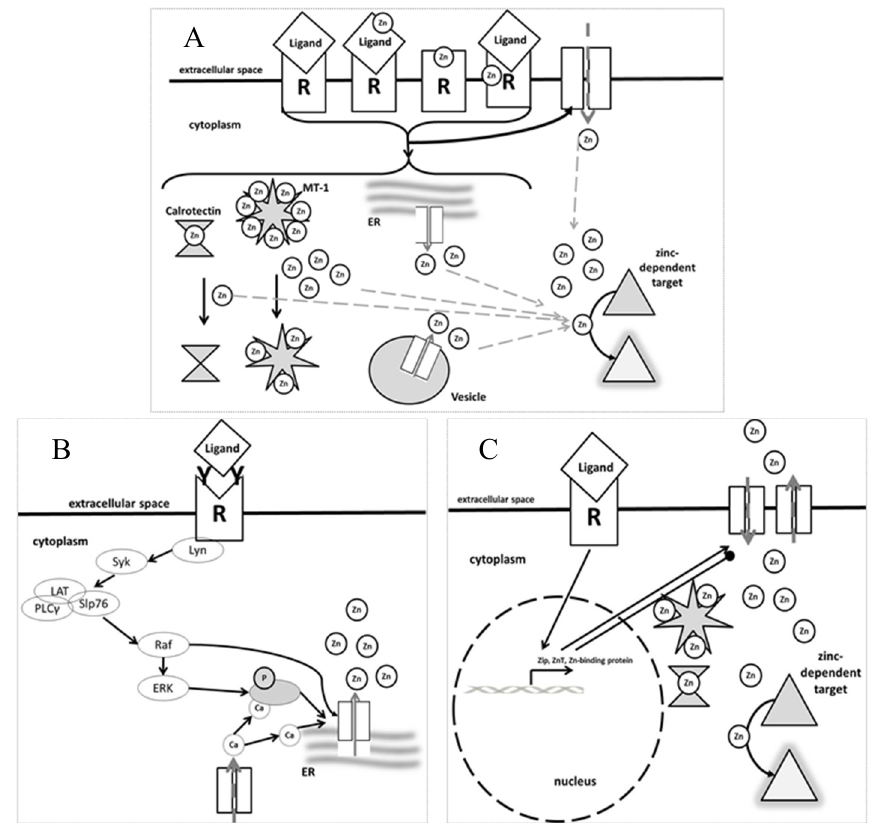
Figure 1. Different Types of Zinc Signals: ( A ) Zinc Flux, as observed after receptor triggering (e.g., binding of lipopolysaccharide (LPS) to Toll like receptor (TLR)4), is generated within seconds. ( B ) A Zinc Wave, as is induced via immunoglobulin receptors and involving calcium flux, can be observed within a few minutes. ( C ) Homeostatic Zinc Signals, for example as observed after LPS stimulation of dendritic cells, take a few hours to be established and involve the expression of zinc transport and binding proteins. For explanations see the text. Abbreviations: ER: endoplasmic reticulum; ERK: extracellular signal ‐ regulated kinase; MT: metallothionein; PLC: phospholipase c; R: receptor; Slp76, SH2 domain ‐ containing leukocyte protein, 76 kD. Modified after [62,96,105].